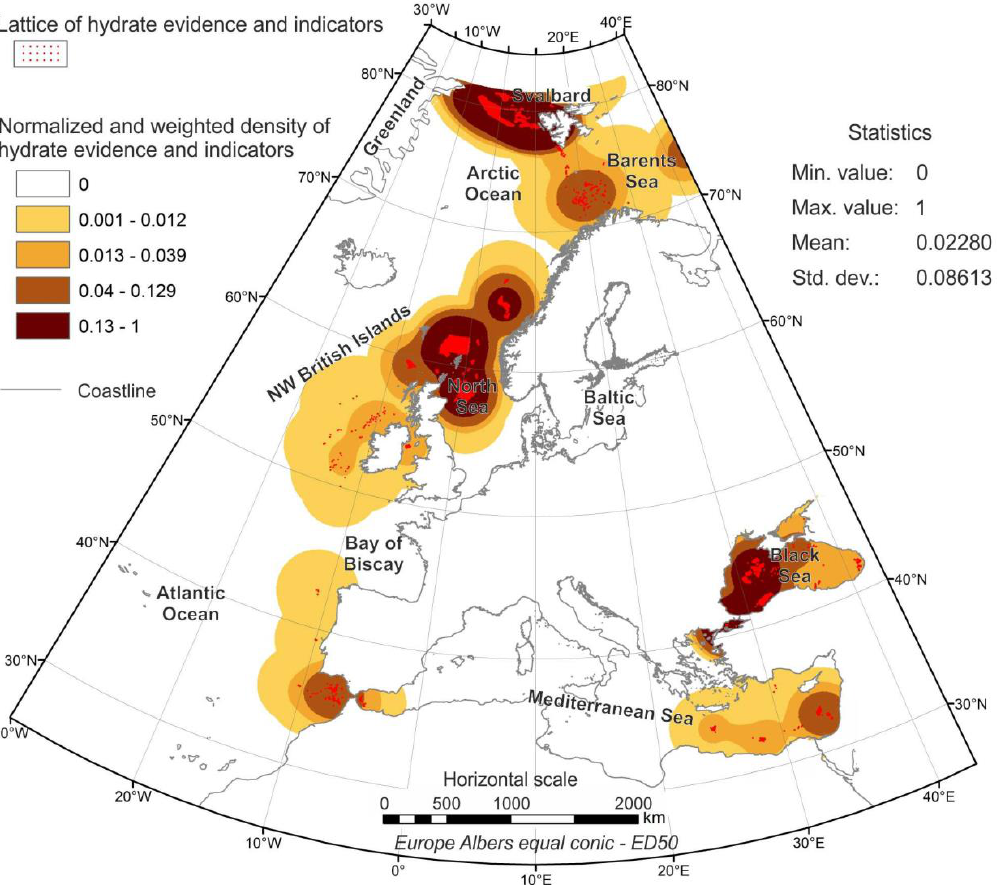
Figure 4. Normalized (zero to one) and weighted density map of hydrate evidence and indicators. Lattice of hydrate evidence and indicators overlapped, red dots. Density map developed with the “kernel density” algorithm of ArcGIS ® . Parameters: population field, weight (taken from Table 3); cell size, 5000; method, geodesic.